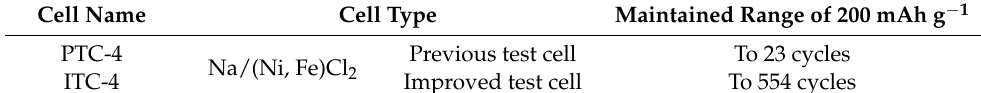
Table 2. Comparison of cycle life between PTC-4 and ITC-4.